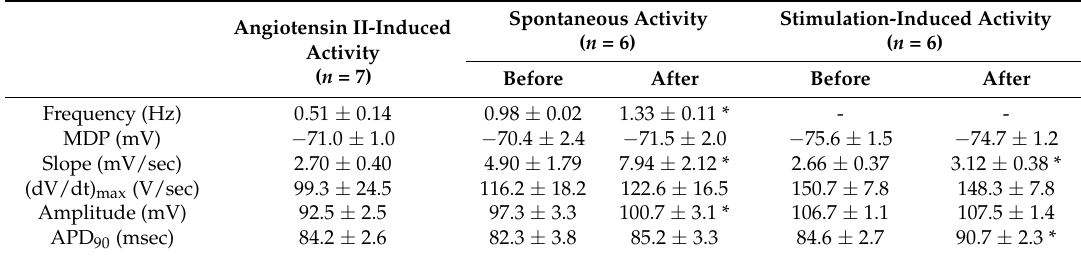
Table 3. Effect of angiotensin II on action potential parameters.